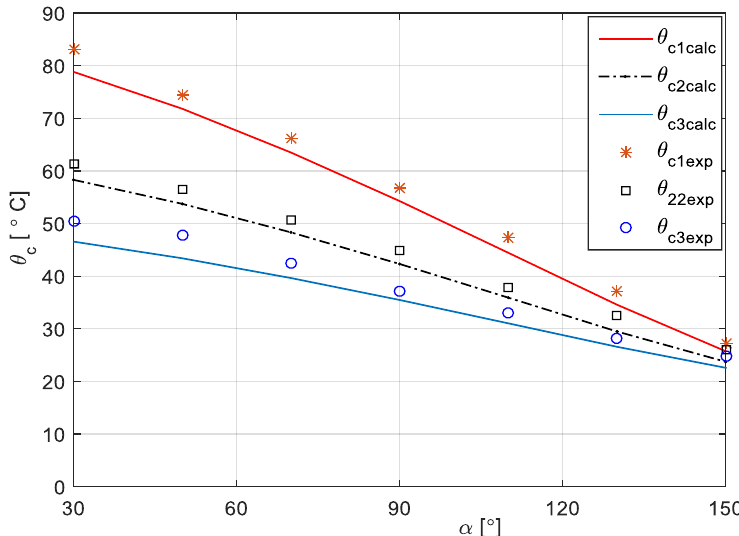
Figure 10. Case temperature variation vs. firing angle at different air speed values of 1; 3 and 6 m/s ( I = 250 A; R = 3 Ω; L = 30 mH).